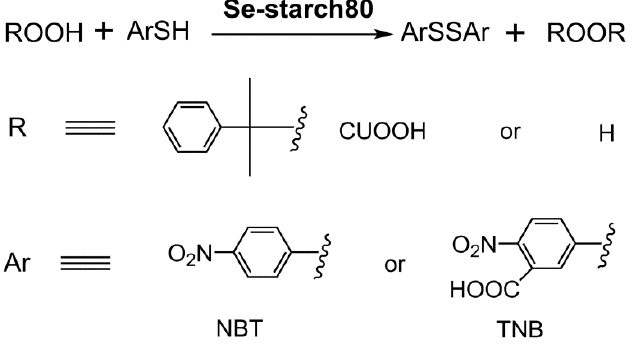
Table 1. The initial rates ( v ) for the reduction of ROOH (250 µM) by ArSH (150 µM) in the pres- 0 ence of Se-starch80 at 25 °C and pH 7.0 (50 mM